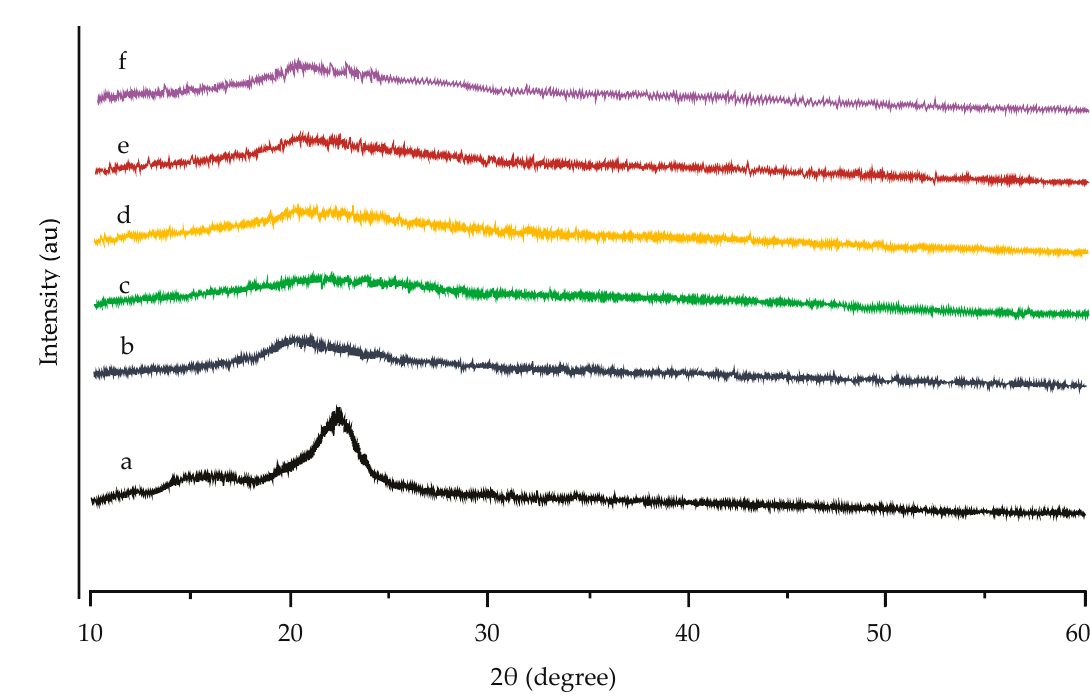
Figure 6. X-ray diffractograms of (a) cellulose from asparagus stalk end and CMC as powder: with (b) 20% ( w / v ) NaOH, (c) 30% ( w / v ) NaOH, (d) 40% ( w / v ) NaOH, (e) 50% ( w / v ) NaOH and (f) 60% ( w / v ) NaOH.